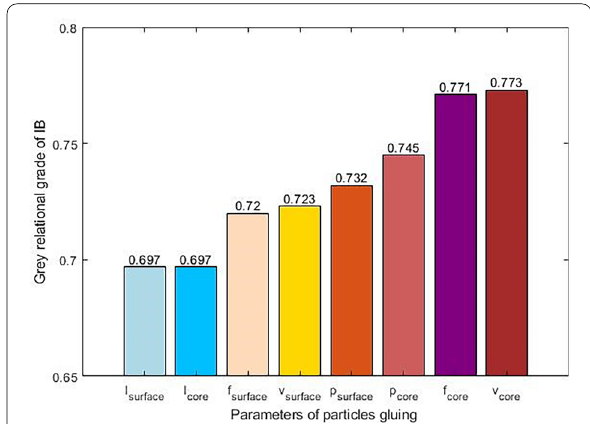
Fig. 5 GRA histogram of particle gluing processing parameters and IB of